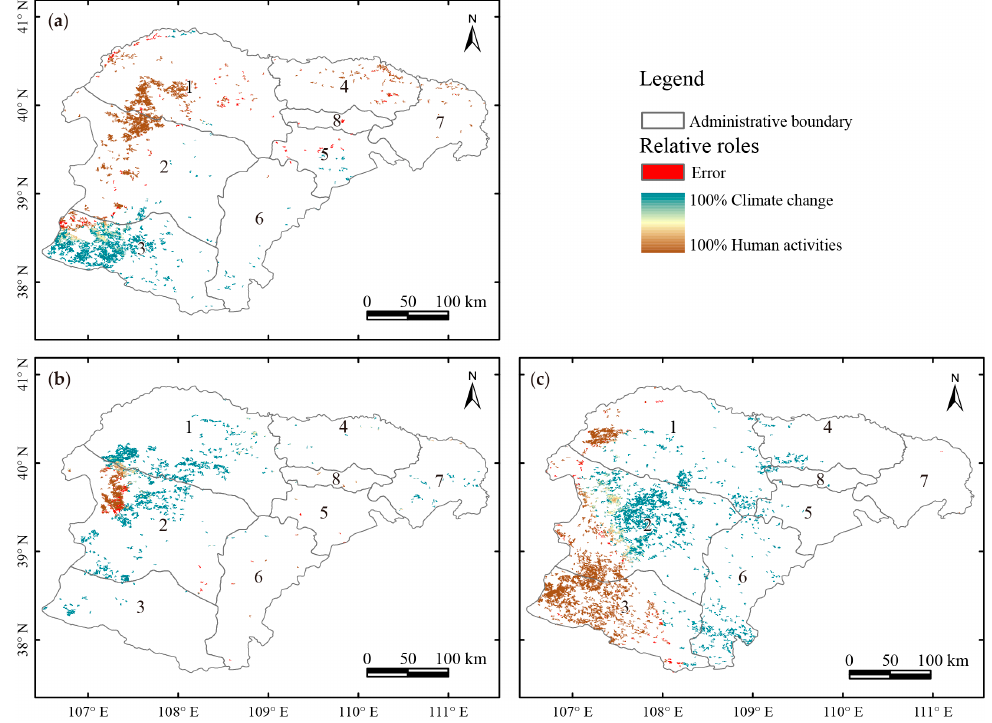
Figure 8. The relative roles of climate change and human activities in desertification expansion for ( a )